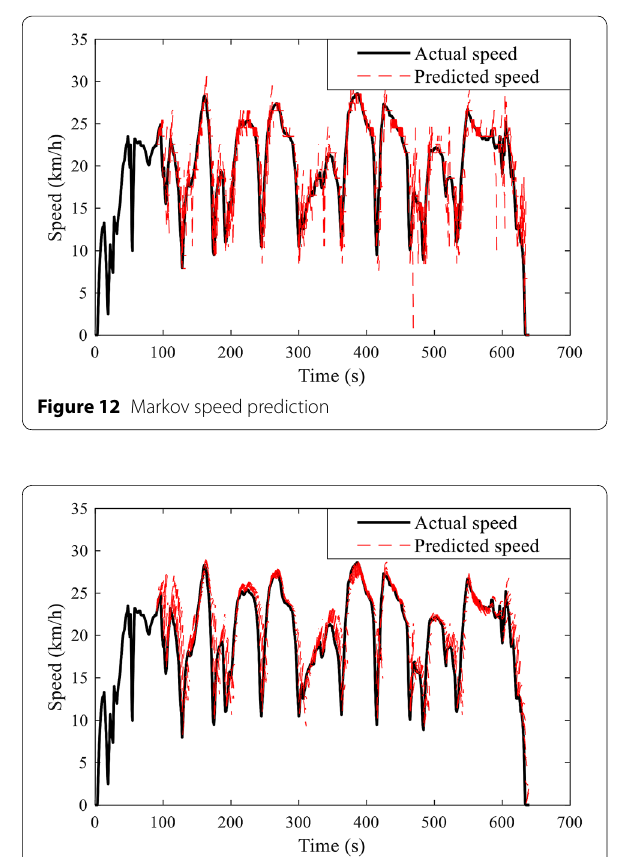
Figure 16 MBNN3 speed